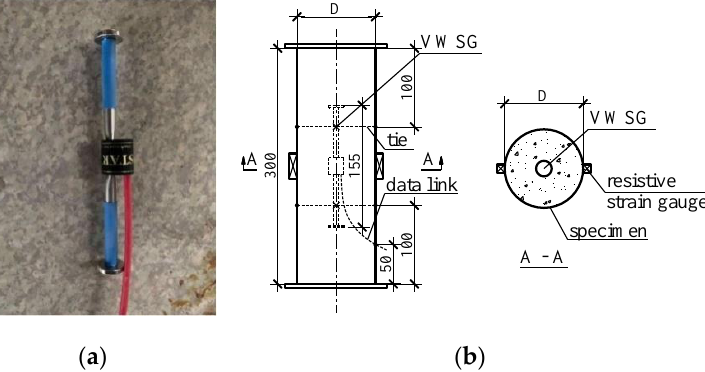
Figure 1. Strain gauges embedded in cylindrical specimen: ( a ) vibrating wire strain gauge (VWSG), ( b ) positions of strain gauges in specimen.